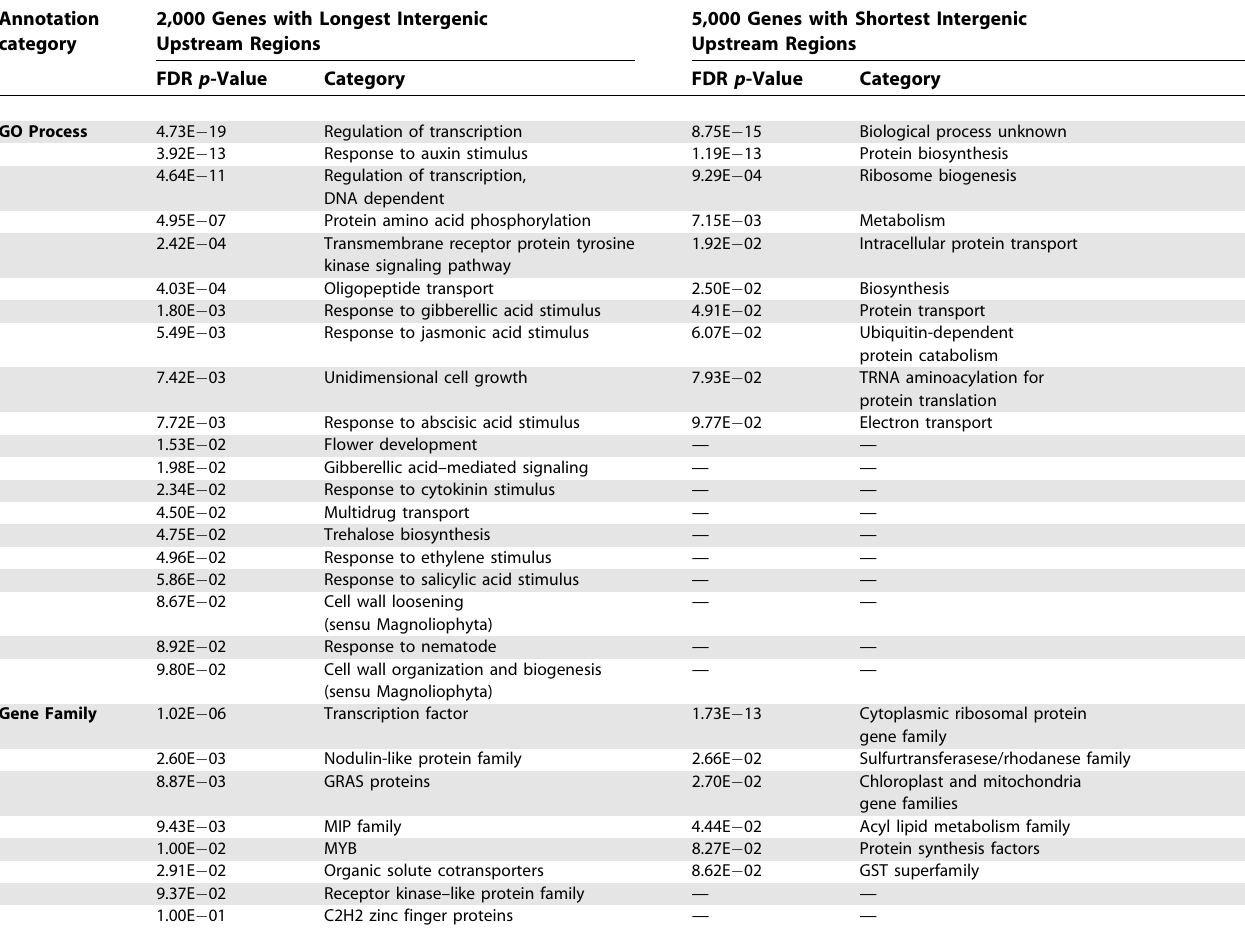
Table 2. GO Process and Gene Family Annotations Overrepresented in Genes with Long (Left) and Short (Right) Intergenic Distances to Next Upstream Gene (FDR p -Value ,